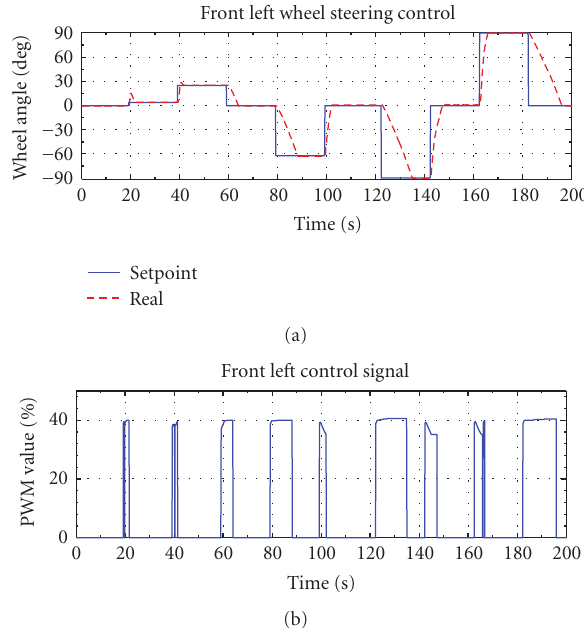
Figure 8: Front right wheel. (a) Wheel steering response comparing desired and real position. (b) Dynamic of PWM applied.